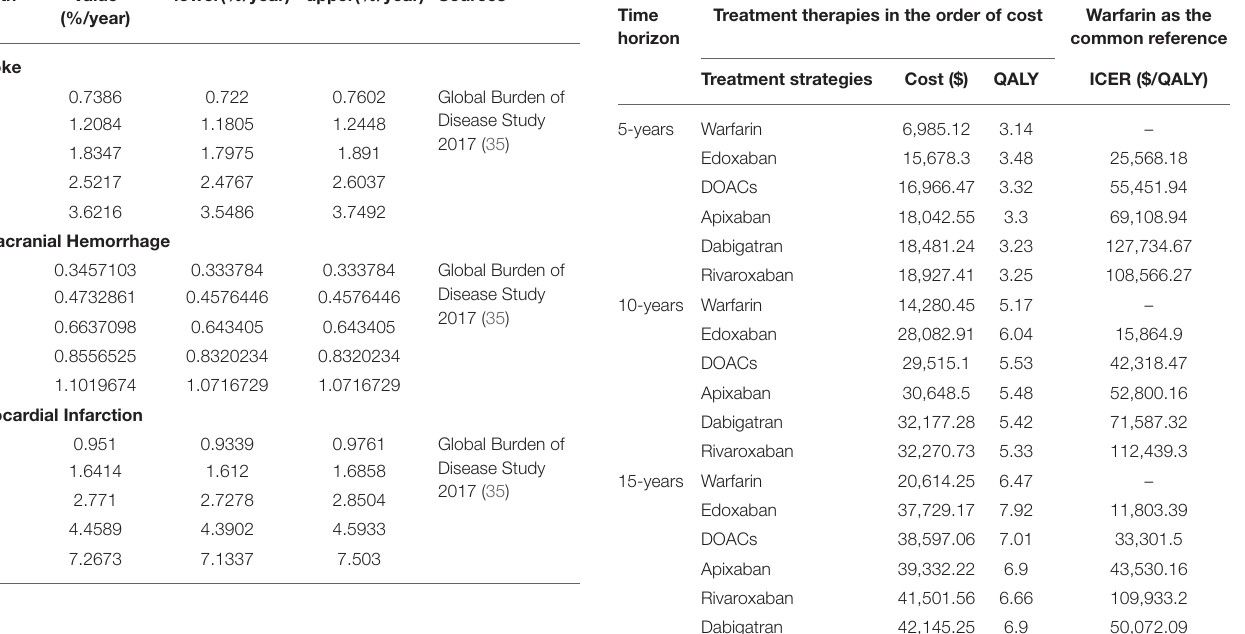
TABLE 4 | Base case analysis and one-way sensitivity analysis on the time horizon. Time Treatment therapies in the order of horizon